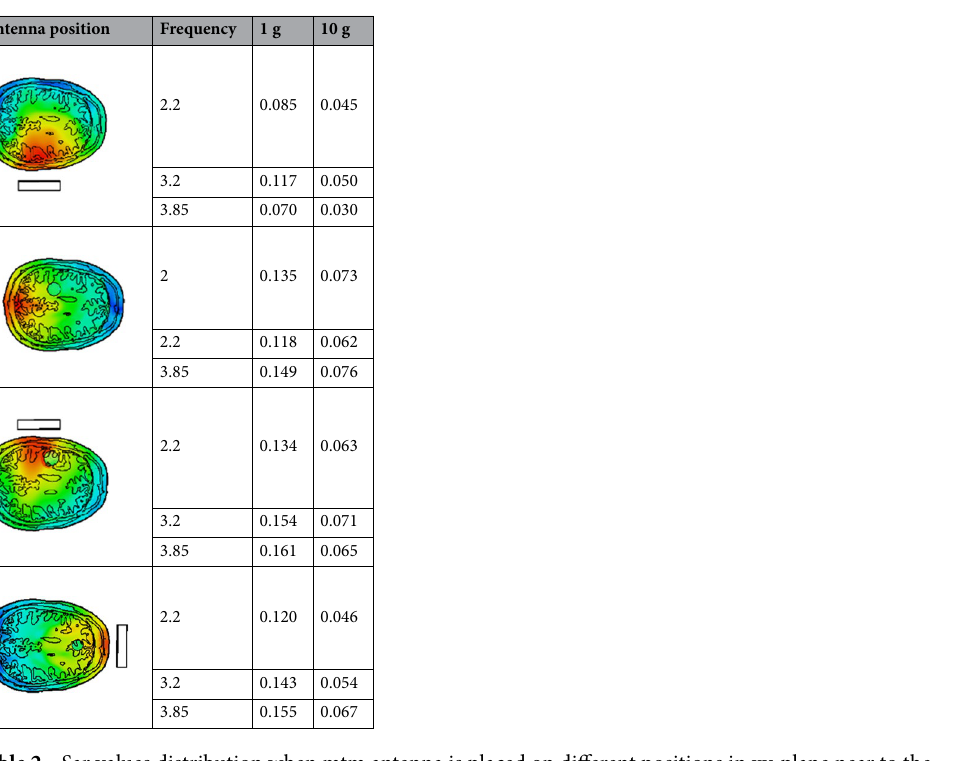
Table 2. Sar values distribution when mtm antenna is placed on different positions in xy-plane near to the head model.